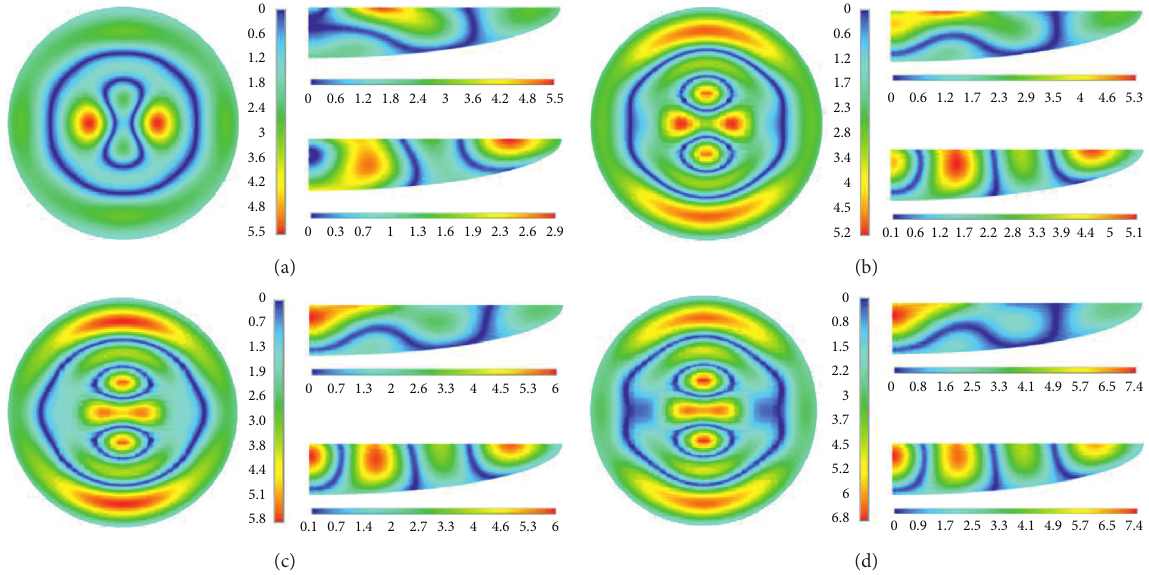
Figure 7: The displacement amplitude of the homogeneous sedimentary basin ( f � 1.0 Hz): (a) no buildings; (b) buildings 14 × 14; (c) buildings 20 × 20; (d) buildings 26 ×